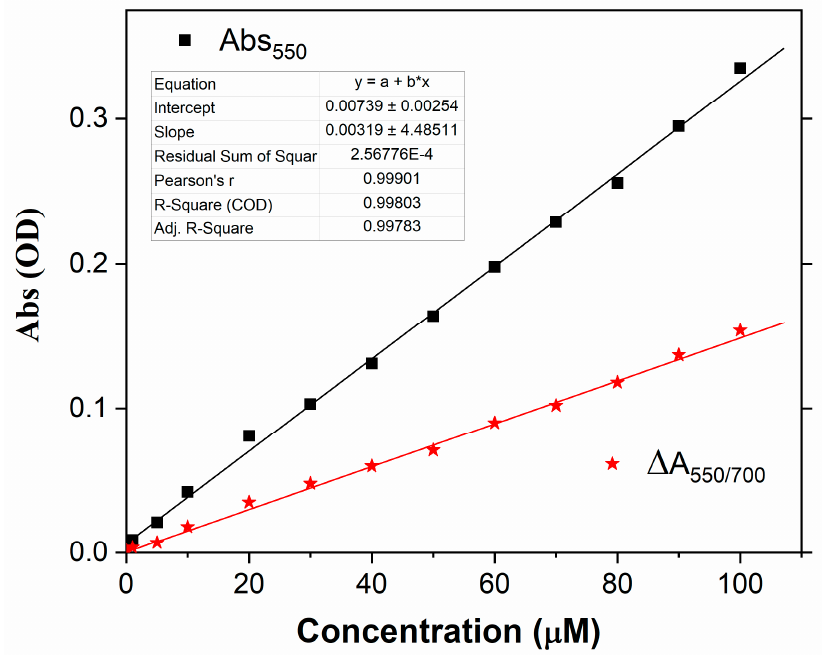
Figure 5. Absorbance at 550 nm (squares) and absorbance difference Δ A 550/700 as a function of Cr(VI) concentration in water.